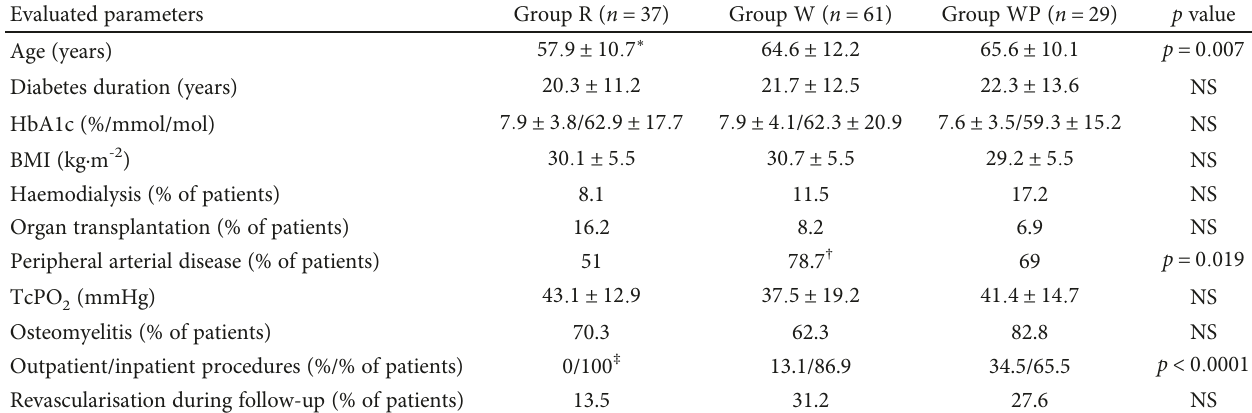
Table 1: A comparison of basic characteristics among the study